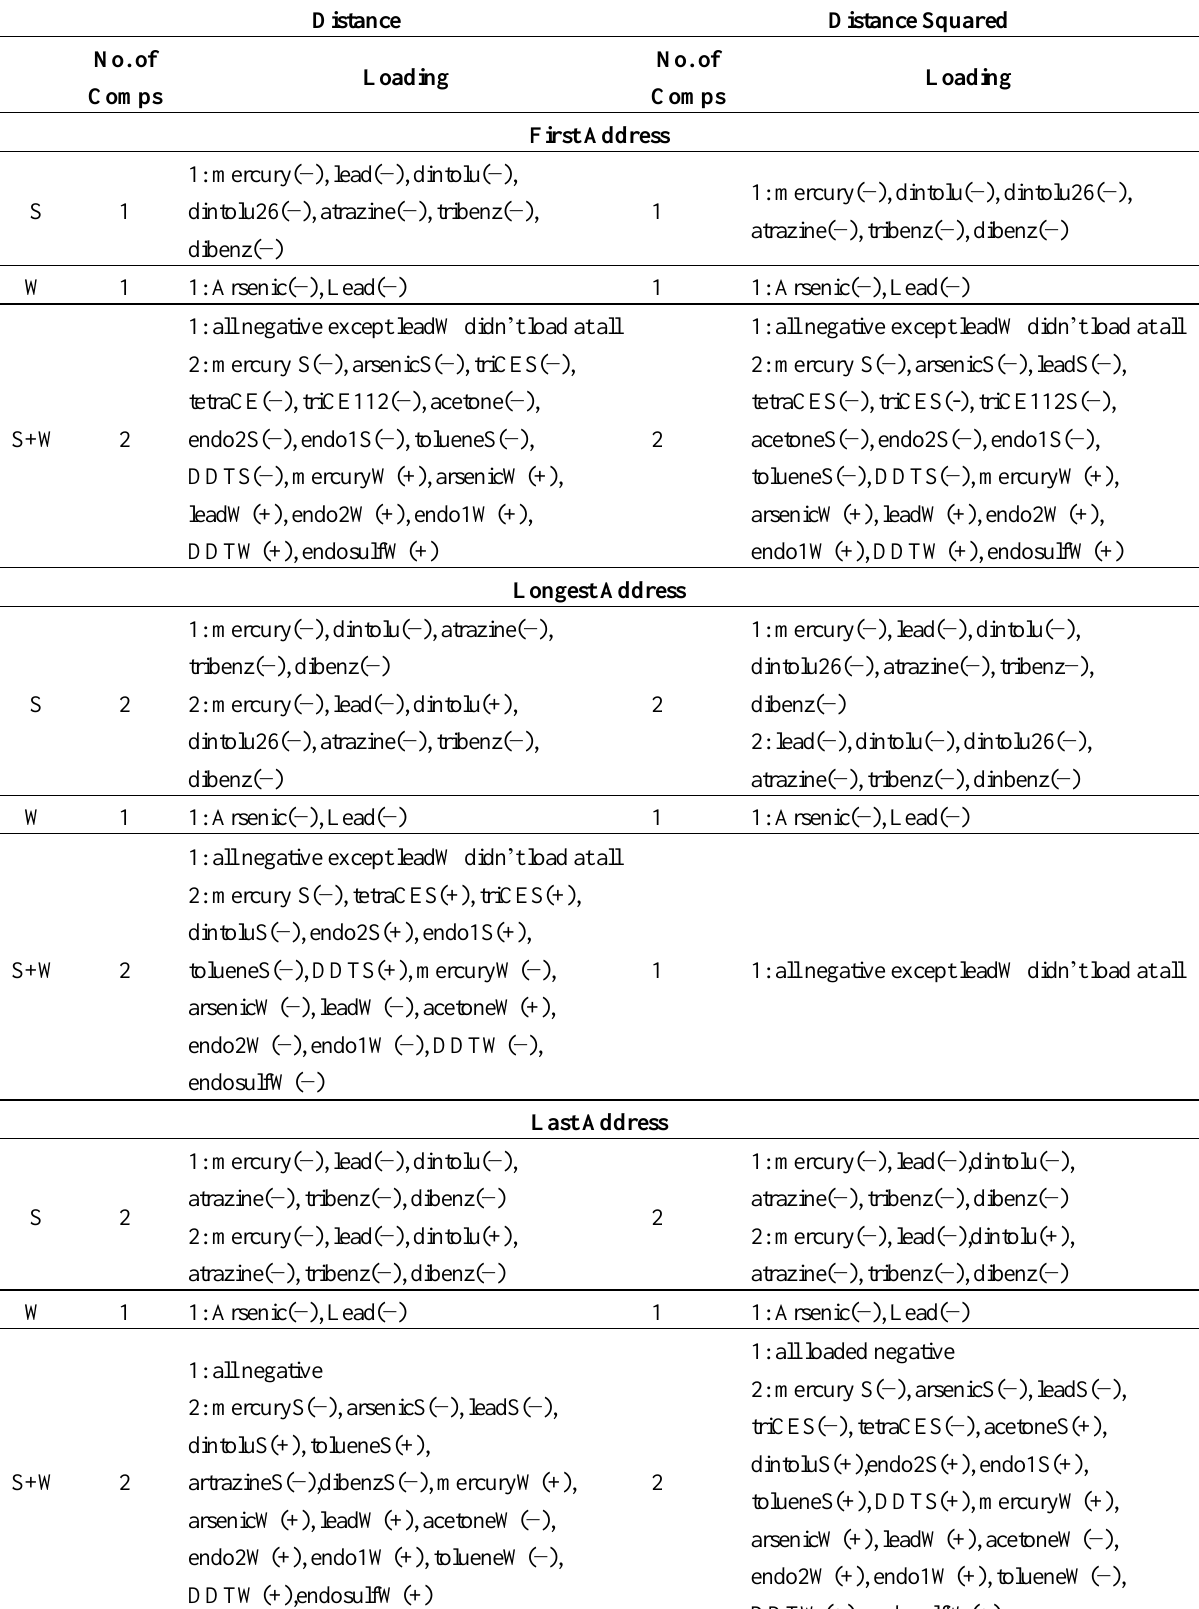
Table 3. PCA loadings and directions (+/−) for the first, longest, and last addresses in that order broken down by soil only (S), ground water only (W), and the joint of soil and ground water (S+G). See Table 2 for description of the variable